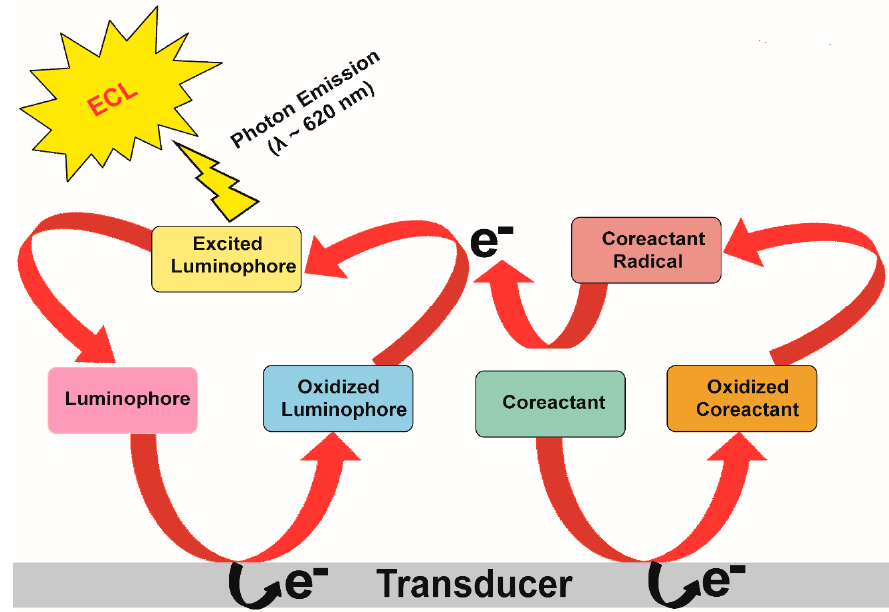
Figure 5. Schematic illustration of ECL mechanism and its generation on electrode surface in presence of suitable luminophore and co-reactant. of suitable luminophore and